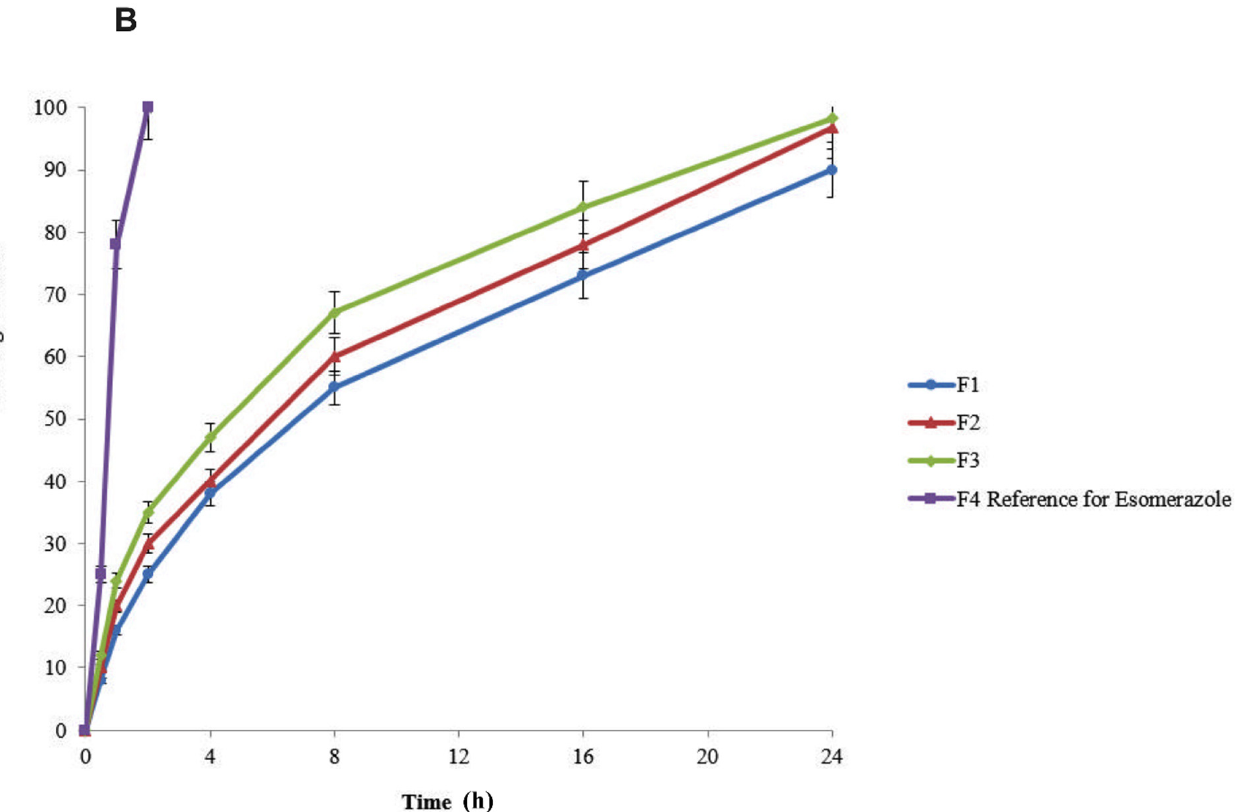
Figure 4. Graphical representation of ( A ) clarithromycin and ( B ) esomeprazole release profiles from controlled-release floating bilayer tablets and reference formulations.